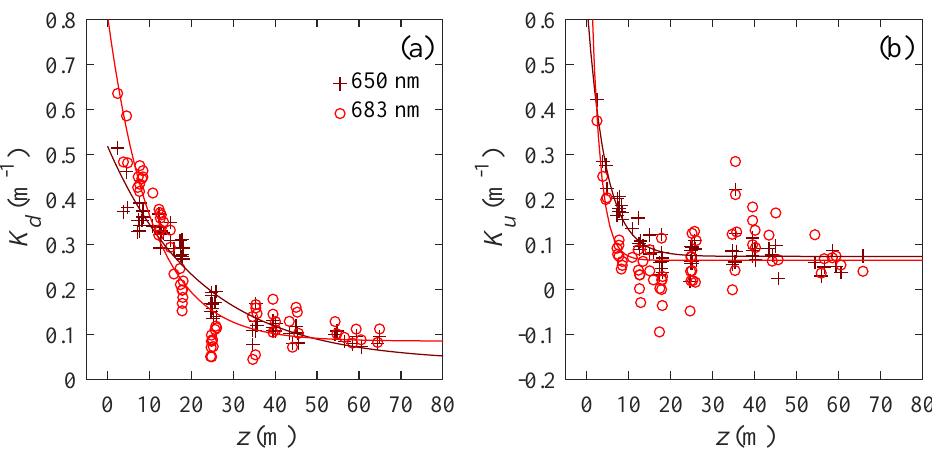
Figure 12. Diffuse attenuation coefficients in the red spectral bands (650 and 683 nm) plotted as a function of depth z using data from all stations and depths. ( a ) K d ( z , 650) (crosses) and K d ( z , 683) (open circles) vs. z . ( b ) Same as ( a ) but for K u . Solid lines represent the best-fit regression functions.